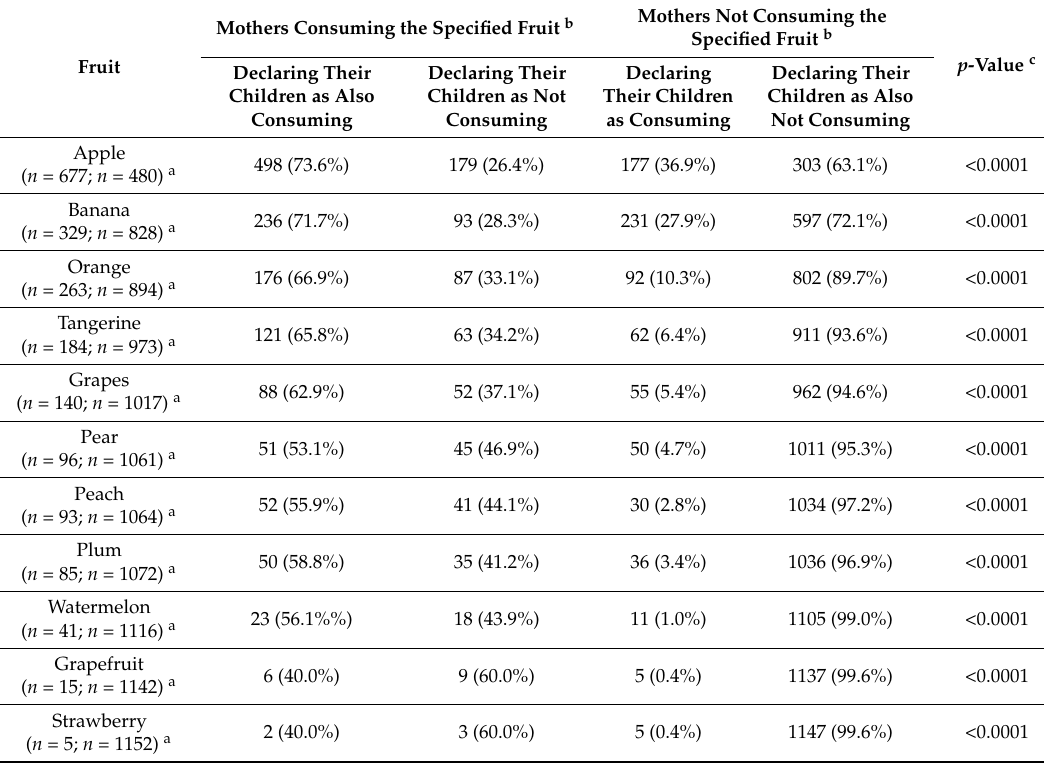
Table 2. Analysis of the association between the fruit consumption behaviors of mothers and their declared fruit consumption behaviors of their children in a national sample of Romanian respondents ( n =